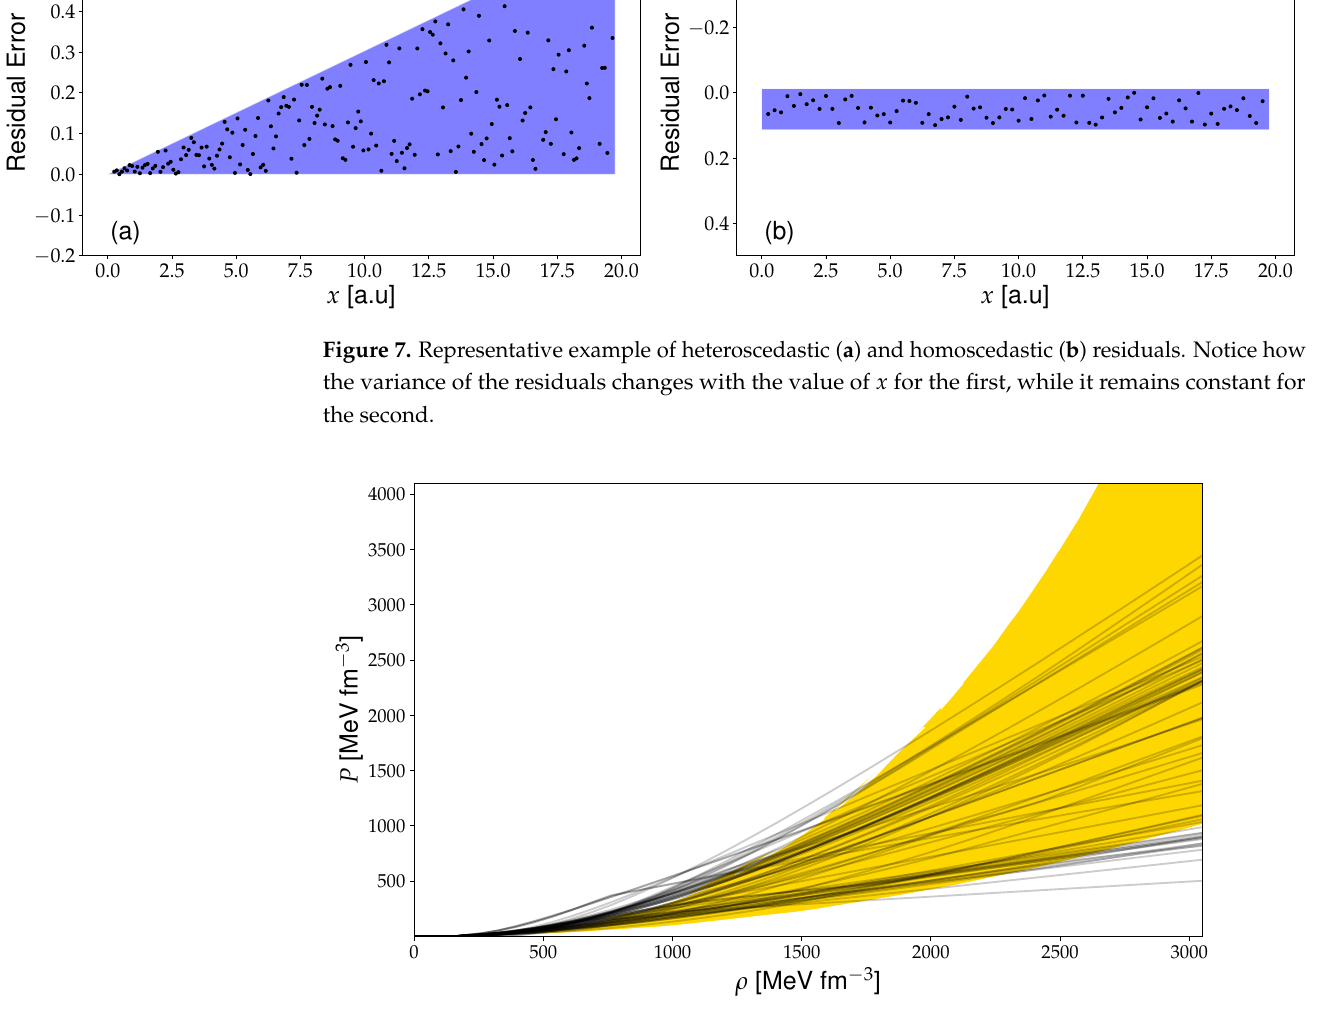
Figure 8. Bayesian Power Regression model heteroscedastic errors. Black solid lines are the 65 EoS from the LIGO Lalsuite [92] data set, while the yellow ones are posterior samples generated by the BPR-HE